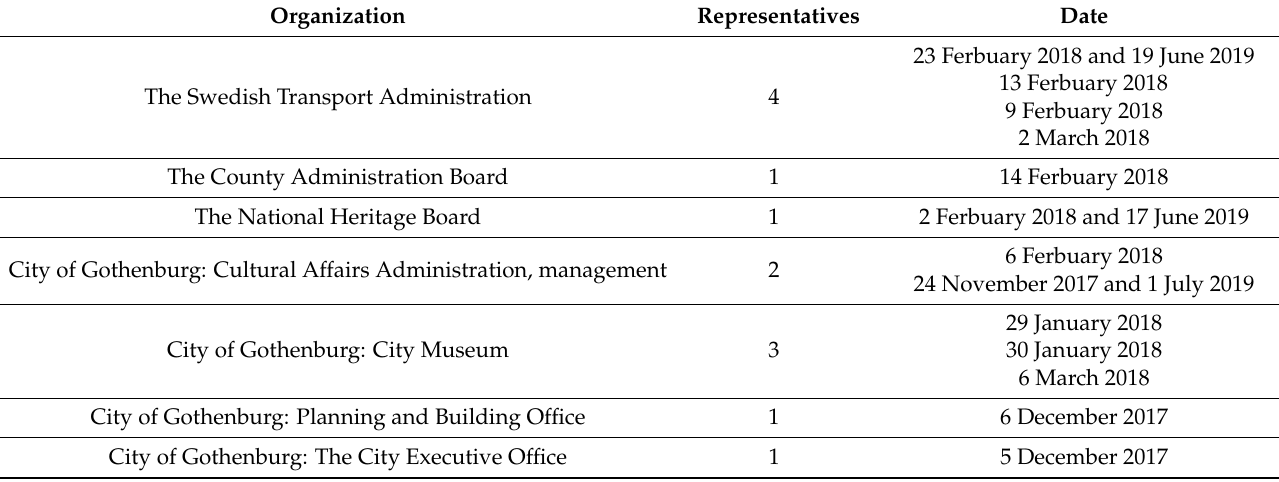
Table 3. List of respondents. Organization, number of representatives and date of interview.